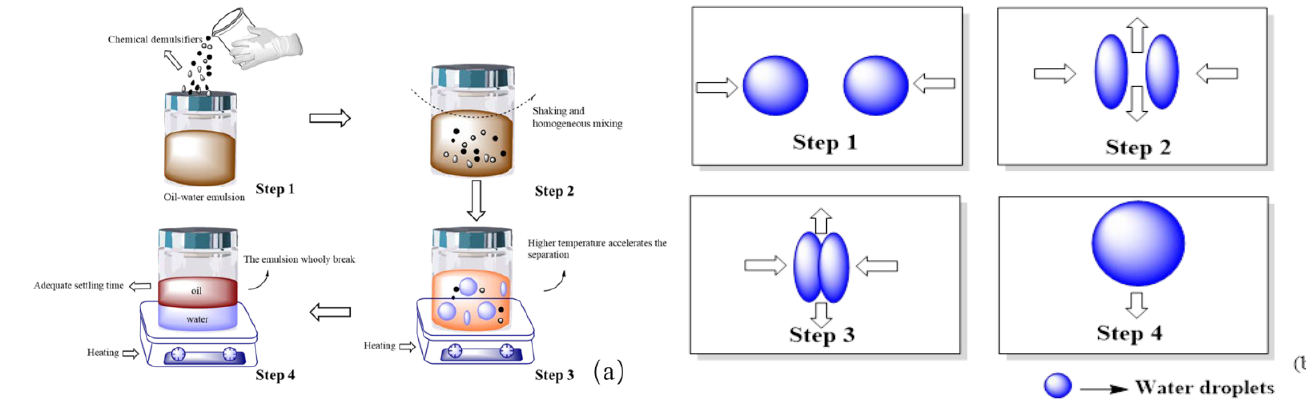
Figure 8. The processes of water–oil emulsion separation, ( a ) the four efficient steps to separate oil–water emulsion, and ( b ) the common demulsification process [157,158].